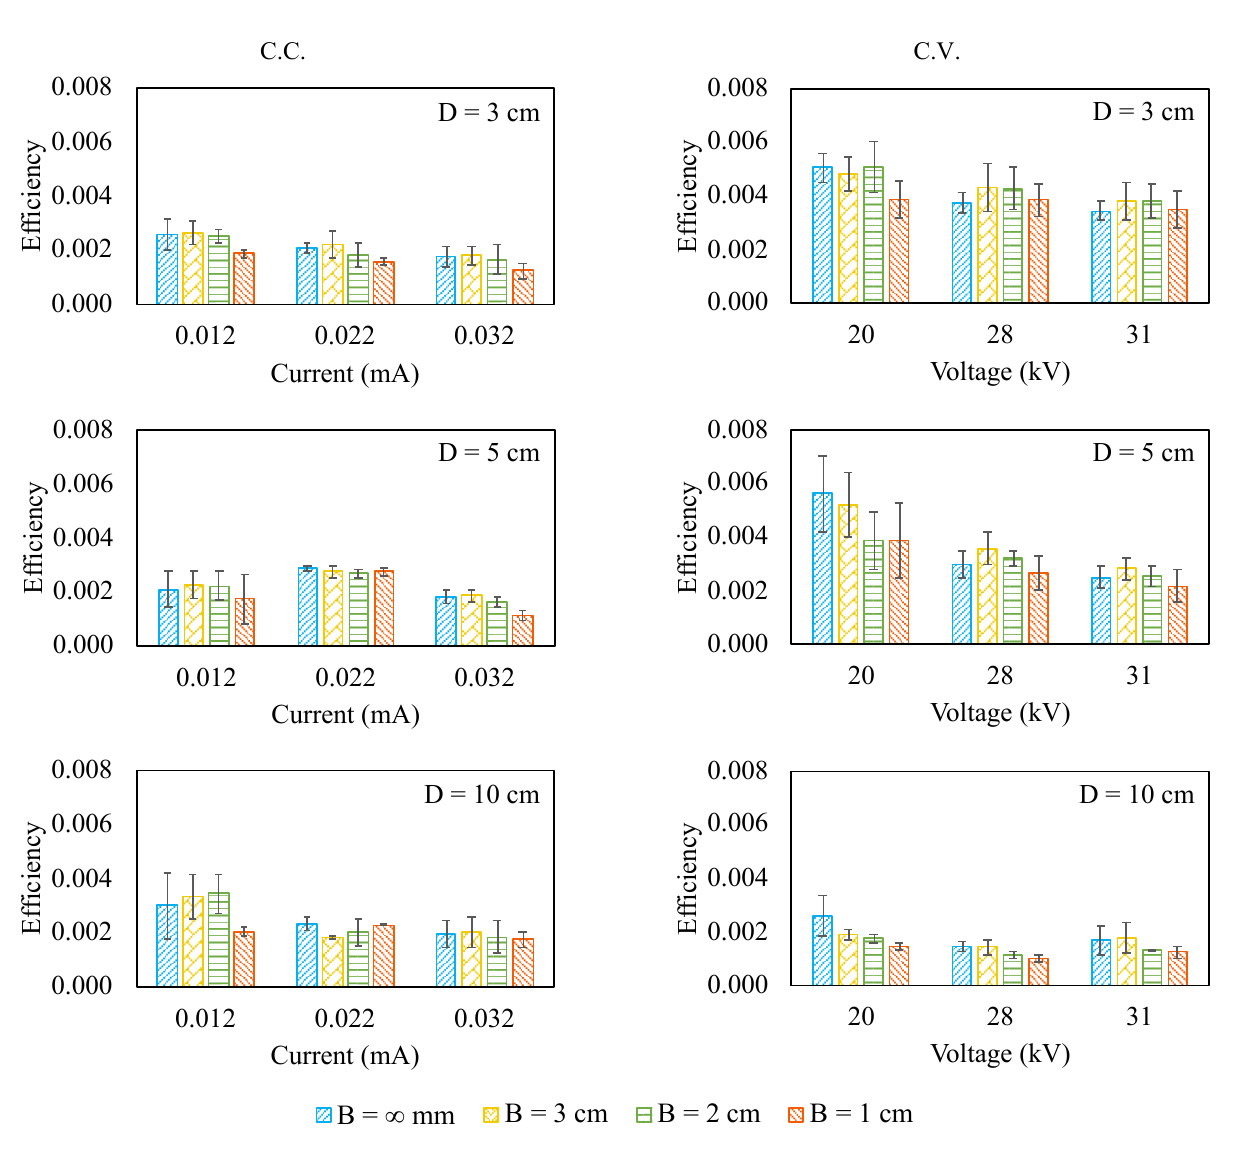
η where is the energy efficiency, m  is the mass flow rate, V is the airflow velocity, I is V is the corona voltage. the corona current, and e